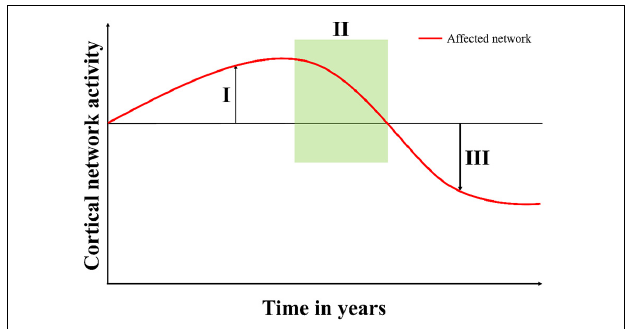
FIGURE 2 | Proposed model of cortical network dysfunction as seen in neurodegenerative diseases. When the neurodegenerative disease starts to affect a cortical network, (I) the compensation phase shows increased activity in the affected network (microstate D). This continues until the network can no longer compensate and then the patient starts to present symptoms in (II) the symptomatic phase (time of referral). In (III) the decompensation phase, the network can no longer compensate for the damages, and the activity falls below the previous